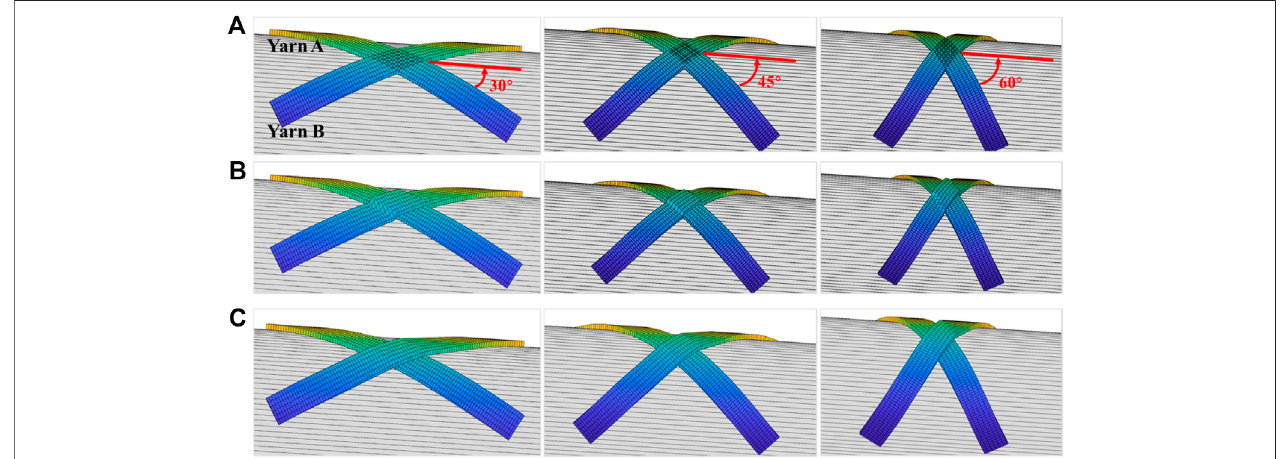
FIGURE 5 | Generation of physically realistic 3D paths for yarns. (A) Before interference processing; (B) the discontinuous 3D paths of yarns after interference processing; (C) continuous 3D paths of yarns after